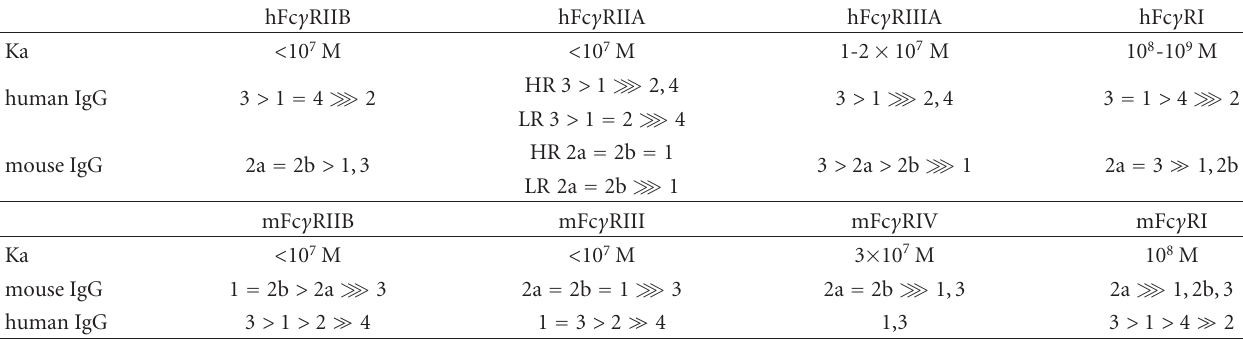
Table 1: A ffi nity of Fc γ R for the IgG. Relative a ffi nity of human and mouse Fc gamma receptors for the di ff erent isotypes of human and mouse Immunoglobulins